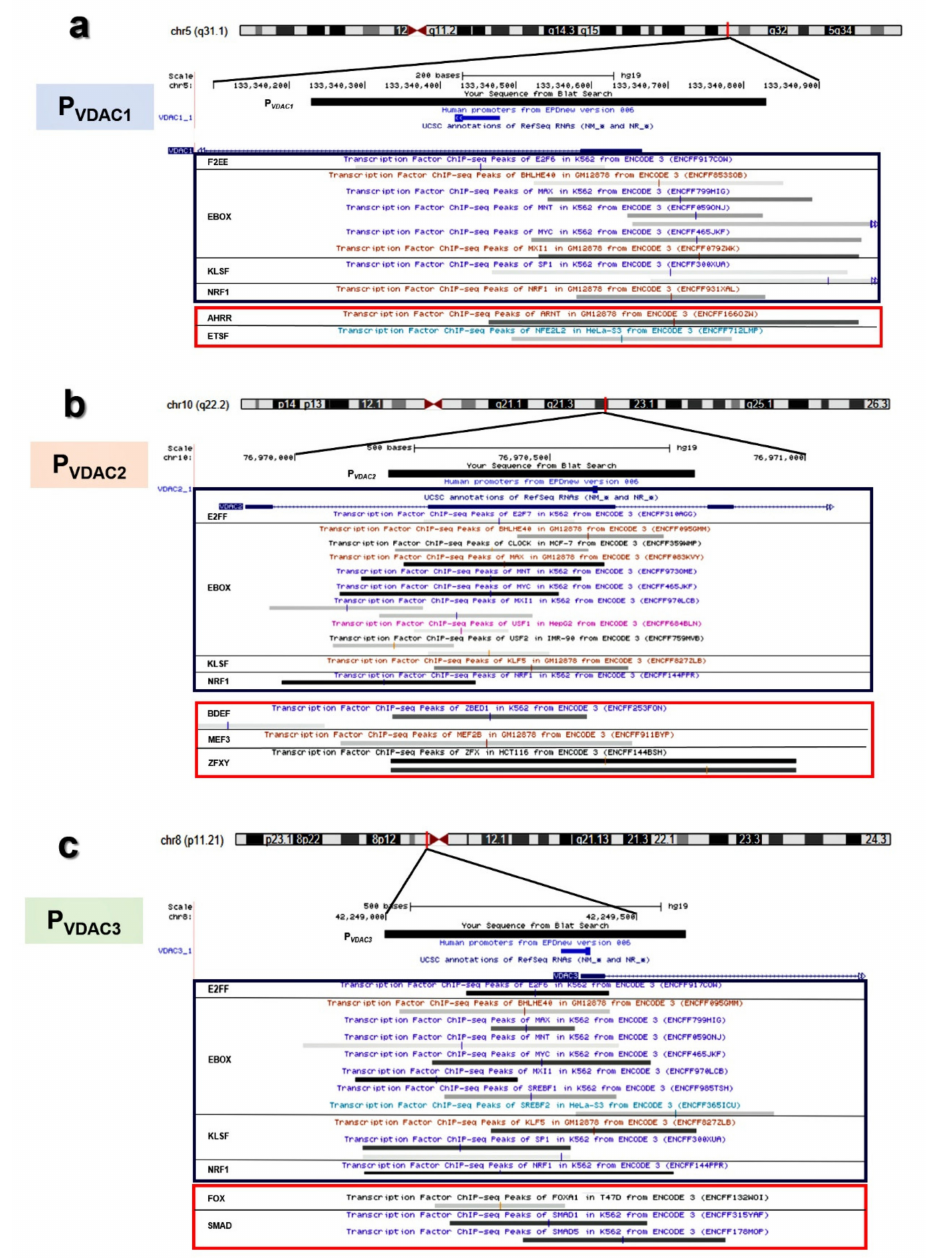
Figure 7. Identification of common and unique transcription factor binding site clusters of VDACs promoter sequences. Distribution of a common set (enclosed in a blue box) and specific sets (enclosed in a red box) of Transcription Factor Binding Sites (TFBSs) in VDAC isoforms promoters as reported in di ff erent cell lines by ChIP-Seq analysis in the ENCODE Project (shown as vertical color bars in the gray segments). ( a ) hVDAC1 , ( b ) hVDAC2 , and ( c ) hVDAC3